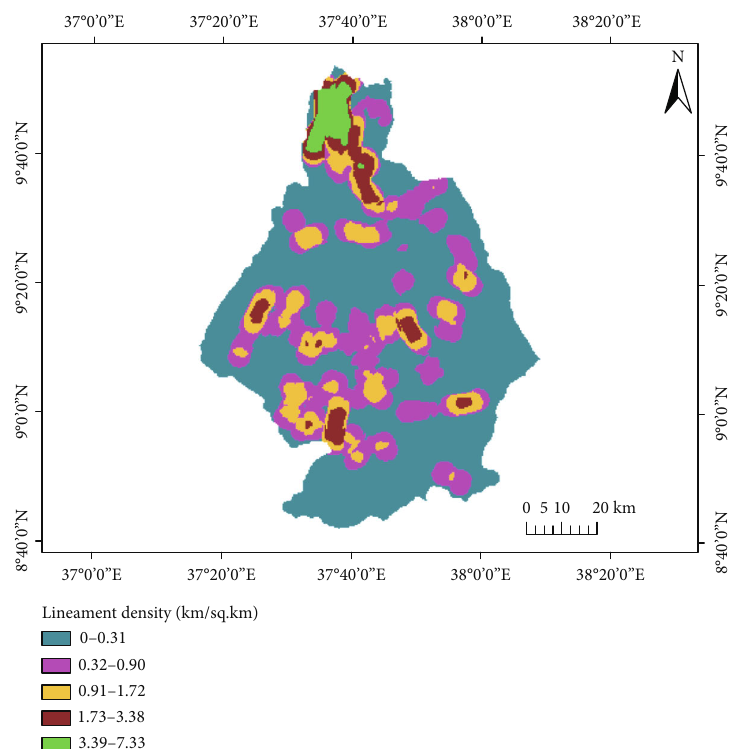
Figure 9: Lineament density map of Guder watershed.